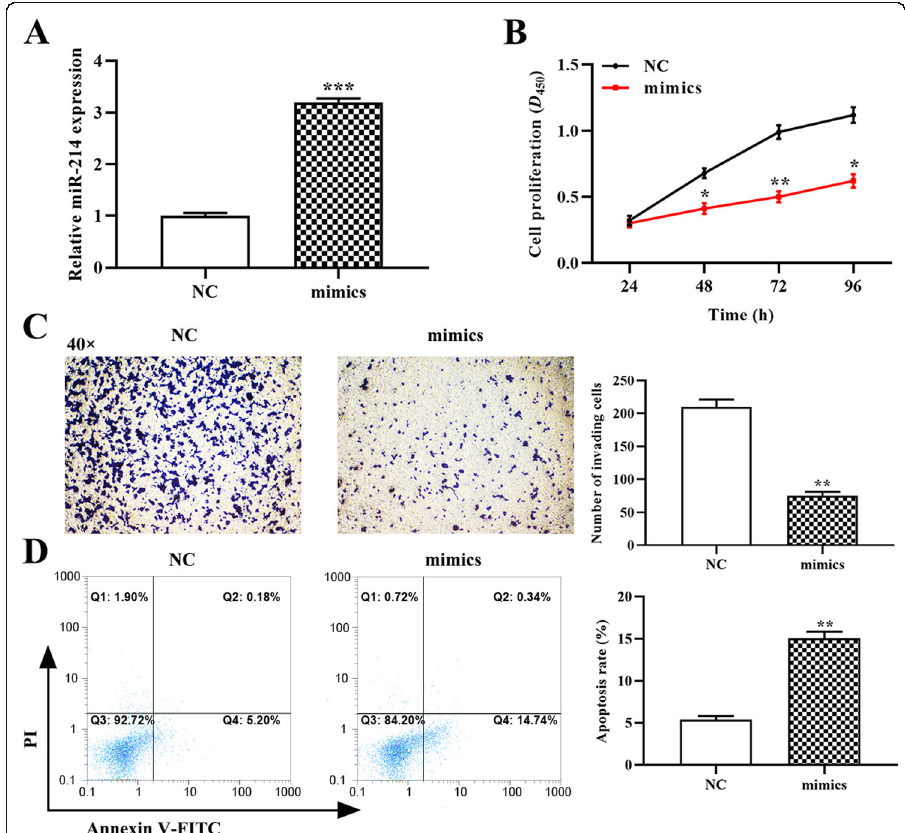
PCR. ( b ) The proliferation of OCI-Ly3 cells was determined using the CCK-8 assay. ( c ) The invasion ability of OCI-Ly3 cells was assessed using a Transwell assay (magnification, × 40). ( d ) The rate of OCI-Ly3 cell apoptosis was measured using flow cytometry. *p < 0.05, **p < 0.01, *** p < 0.001, compared with